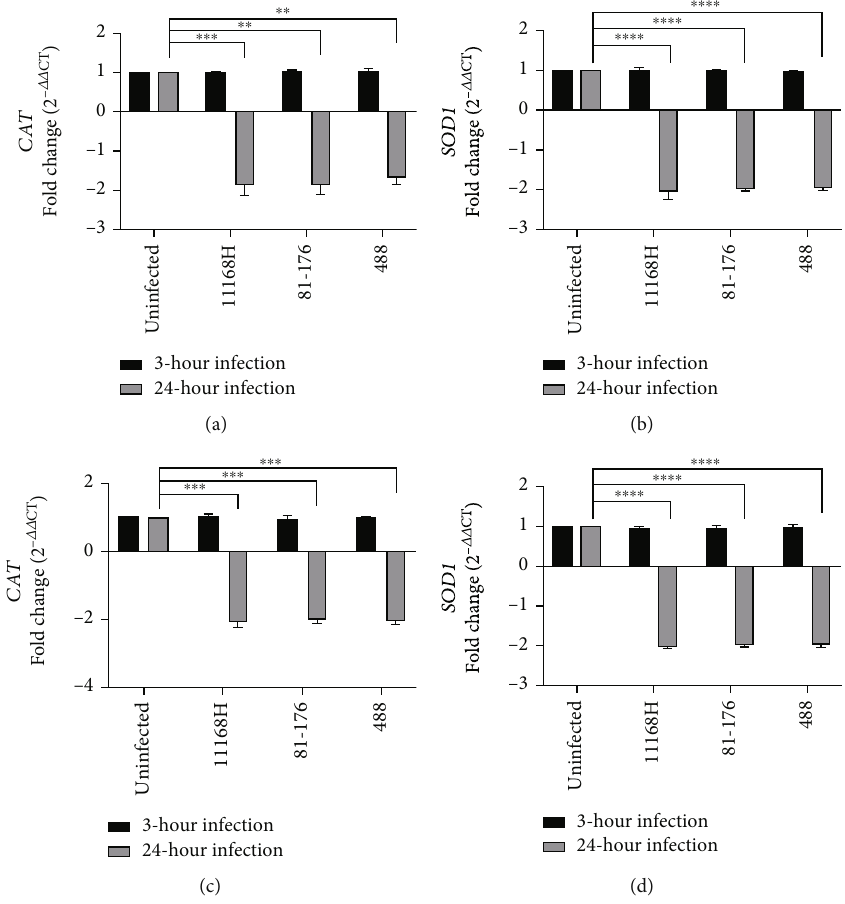
Figure 5: qRT-PCR showing expression of human catalase ( CAT ) and superoxide dismutase 1 ( SOD1 ) in T84 and Caco-2 cells. (a, b) T84 and (c, d) Caco-2 cells were infected with C. jejuni for 3 or 24 hours, and transcriptional levels of CAT and SOD1 were measured. GAPDH was used as an internal control. Experiments were repeated in three biological and three technical replicates. Asterisks denote a statistically signi fi cant di ff erence ( ∗∗ p < 0 : 01 ; ∗∗∗ p < 0 : 001 ; ∗∗∗∗ p < 0 : 0001